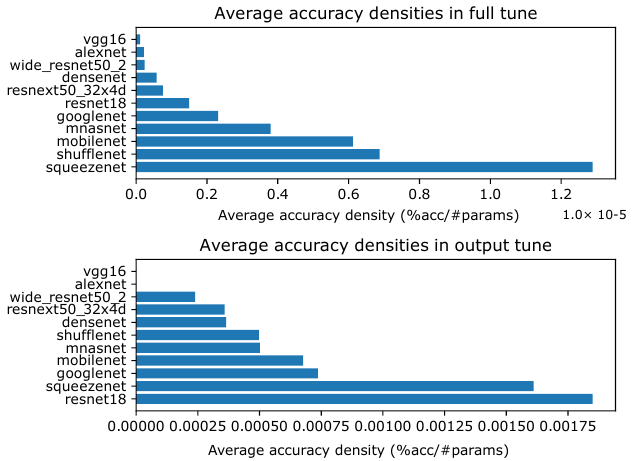
Figure 3. Average accuracy densities with full tuning and tuning the classifier layer only for one episode.